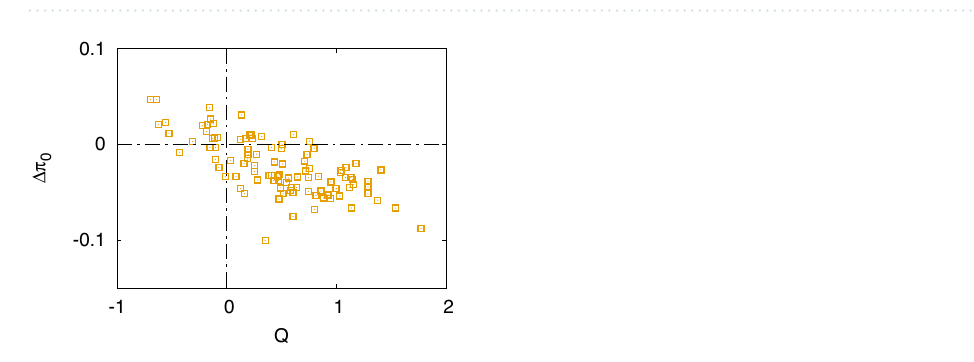
Figure 3. Payoff difference between the resident population using Simple Standing and its ‘slope mutant’, which has the same β and α( 1, 1, 1 ) = 1 but different slopes A x and A y and A z . Each point denotes a randomly generated mutant through the trilinear interpolation among α( 1, 1, 1 ) = 1 and seven random values α( 0, 0, 0 ) , α( 0, 0, 1 ) , . . . , α( 1, 1, 0 ) within the unit interval. The mutant norm occupies 10% of the whole population whose size is N = 100 . The horizontal axis shows the mutant’s Q -value [Eq. (17)], and the vertical axis means its payoff difference �π 0 with respect to the resident norm after a sufficiently long time, e.g., M / N ∼ O ( 10 3 ) . As before, the game is defined with b = 2 and c = 1 , and the observation probability is q = 0.4 . Perception error and implementation error occur with probabilities e = 0.1 and γ = 0.1 ,